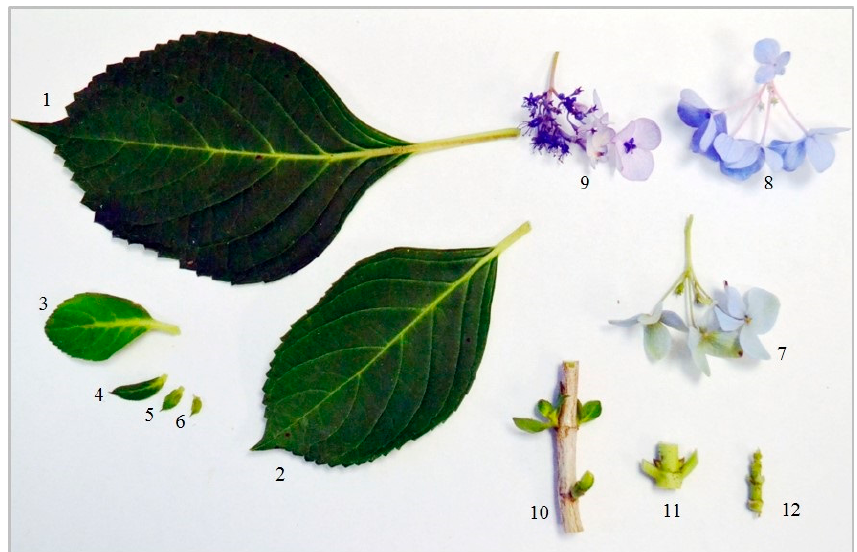
Figure 1. Example of tissue types sampled from a single plant of ‘Veitchii’ and ‘Endless Summer’ for transcriptome sequencing. 1–6: leaf tissues collected at different developmental stages. 7–9: flower tissues collected at different flowering times; 10–12: stem tissues collected from different positions. Bud tissues are not listed in this